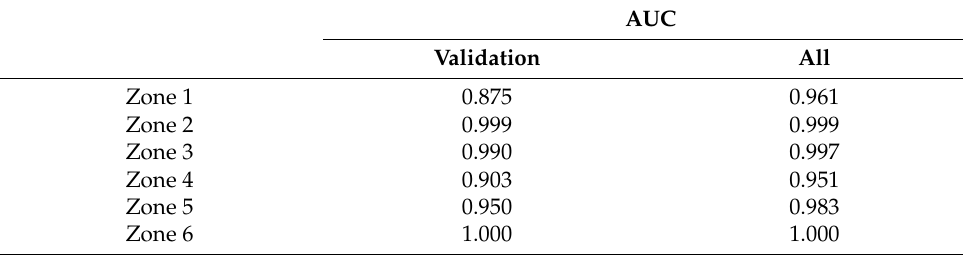
Table 2. AUC performance for each zone, considering the validation dataset and all the data. AUC AUC Validation All